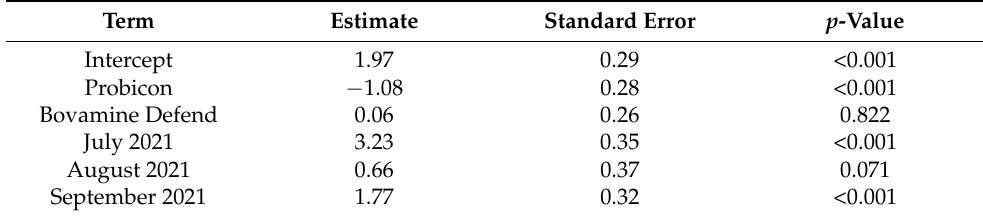
Table 4. Results of the GEE analysis for C. perfringens concentration.